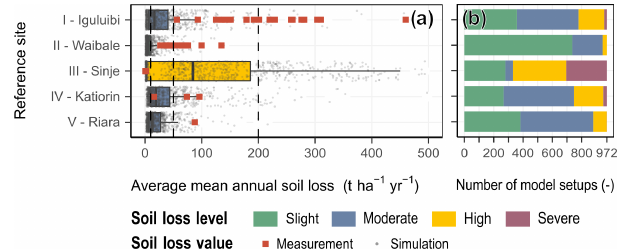
Figure 10. Comparison of soil loss simulations from the USLE model ensemble to in-field soil loss assessments acquired from se- lected studies. The reference soil loss values are shown with red squares for sites Iguluibi and Waibale (De Meyer et al., 2011), Sinje (Bamutaze, 2010), Katiorin (Sutherland and Bryan, 1990), and Ri- ara (Kithiia, 1997) in panel (a) . The soil loss simulations for the reference extents from all 972 USLE model realizations are shown as grey circles. Corresponding boxplots show summary statistics for the model ensembles in panel (a) . Panel (b) summarizes the num- bers of models that predicted the soi loss levels slight (green), mod- erate (blue), high (orange), and severe (purple) for the reference